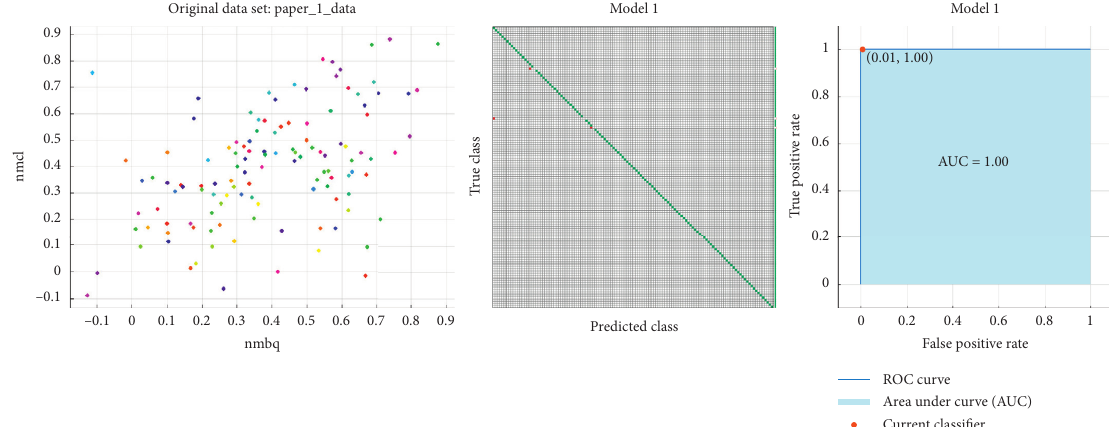
Figure 10: Gait recognition with Cross-Correlation Score, confusion matrix, and ROC curve of